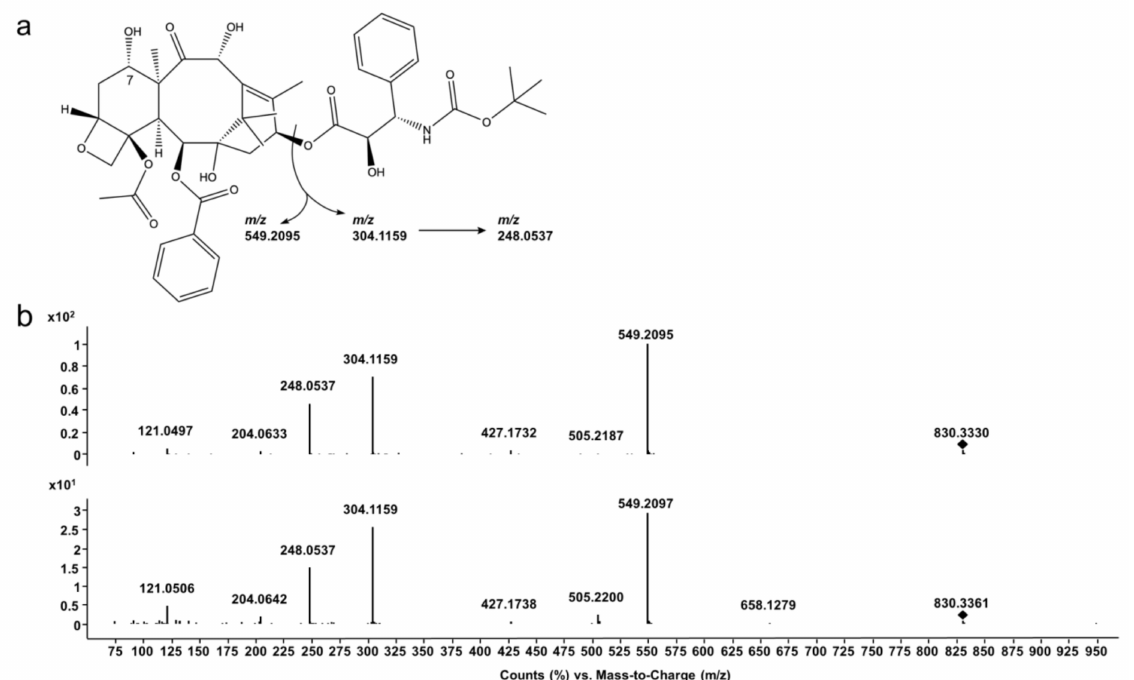
Figure2. Docetaxelstructurefragmentation. ( a